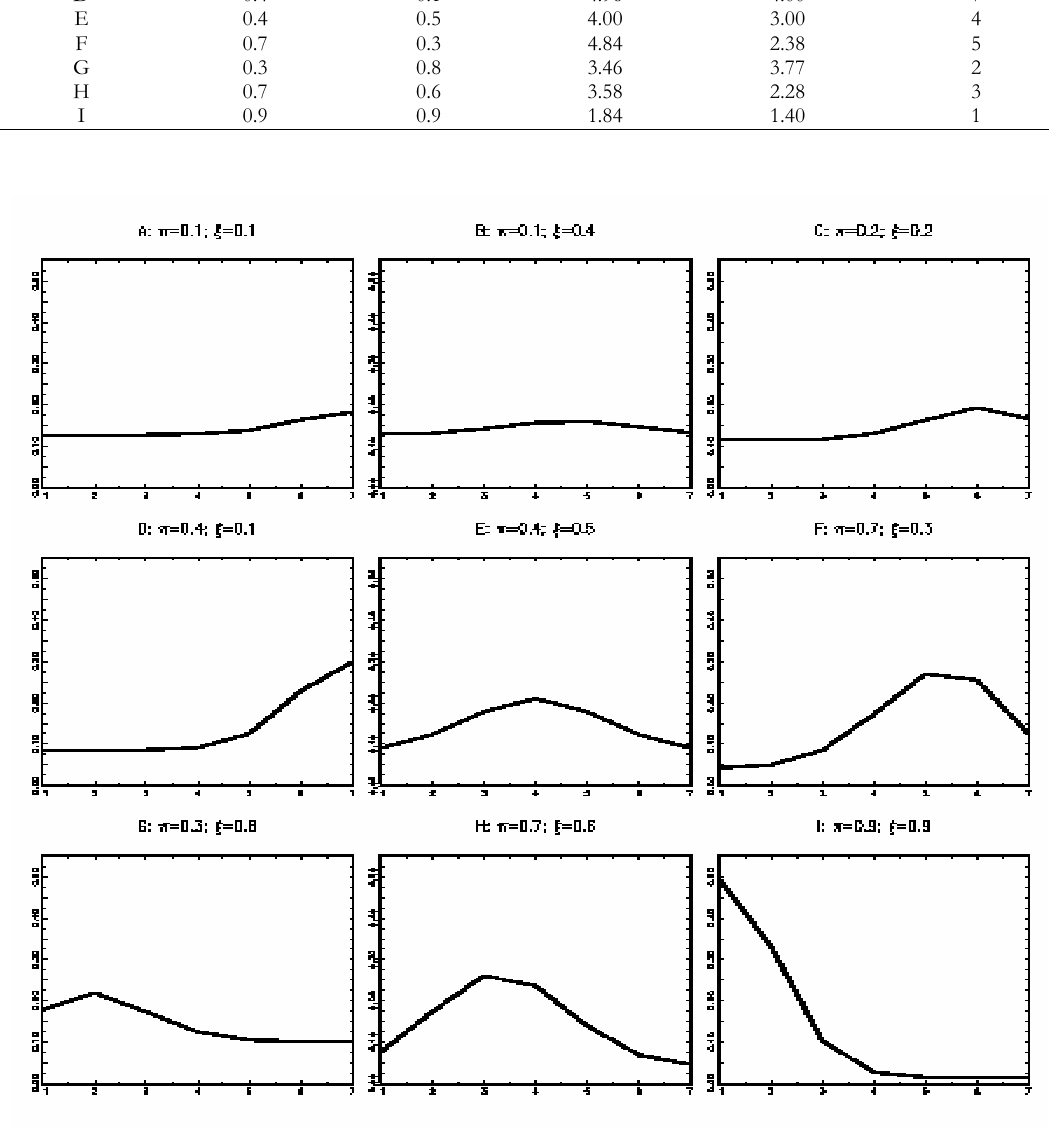
Figure 1 – Probability distributions for the models in Table